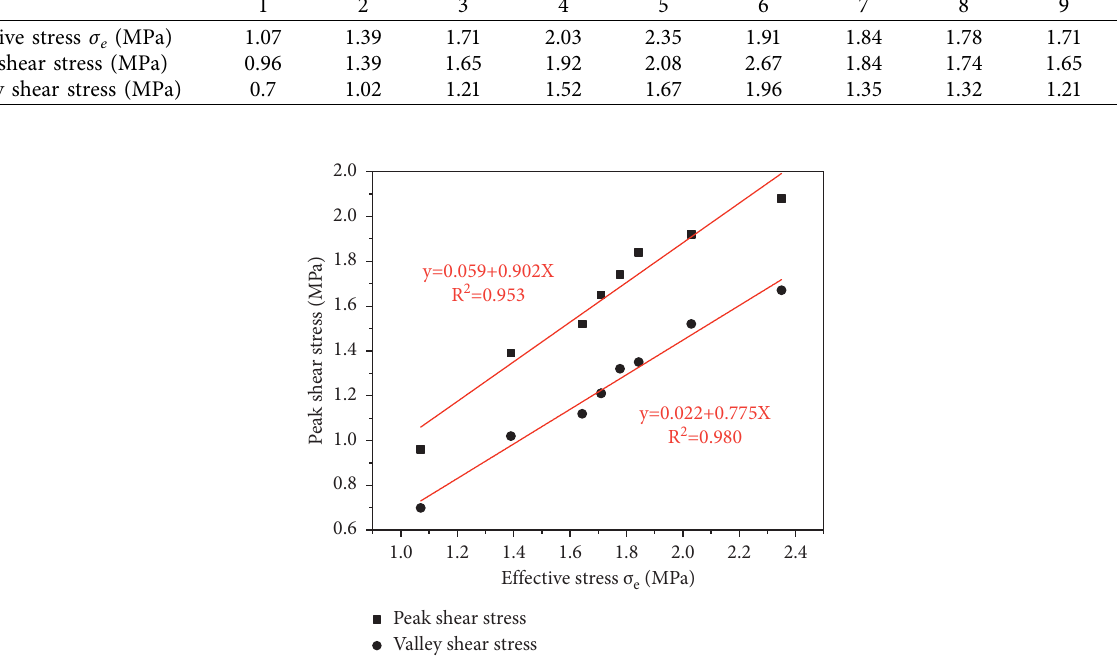
Figure 4: Fitting curve of stress eigenvalue relation.